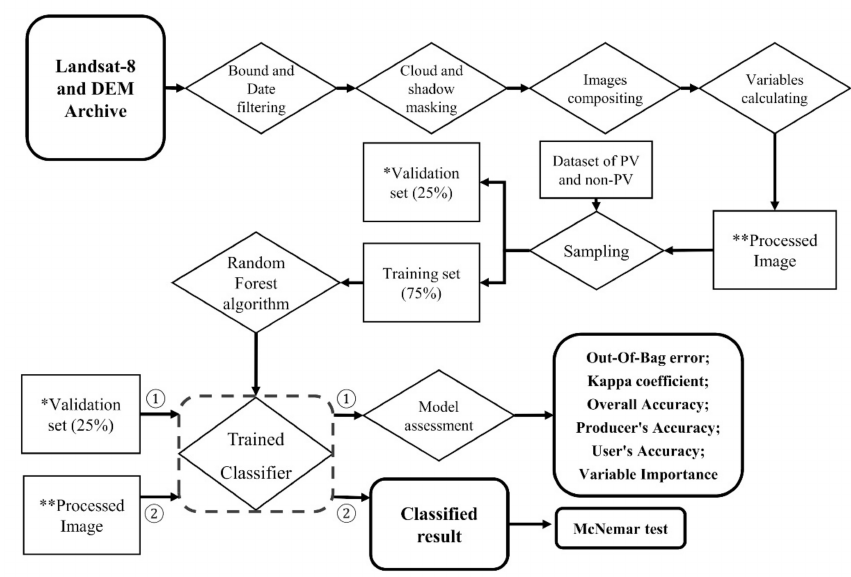
Figure 2. The flowchart of this methodology. Please note the * indicated validation set and the ** indicated processed